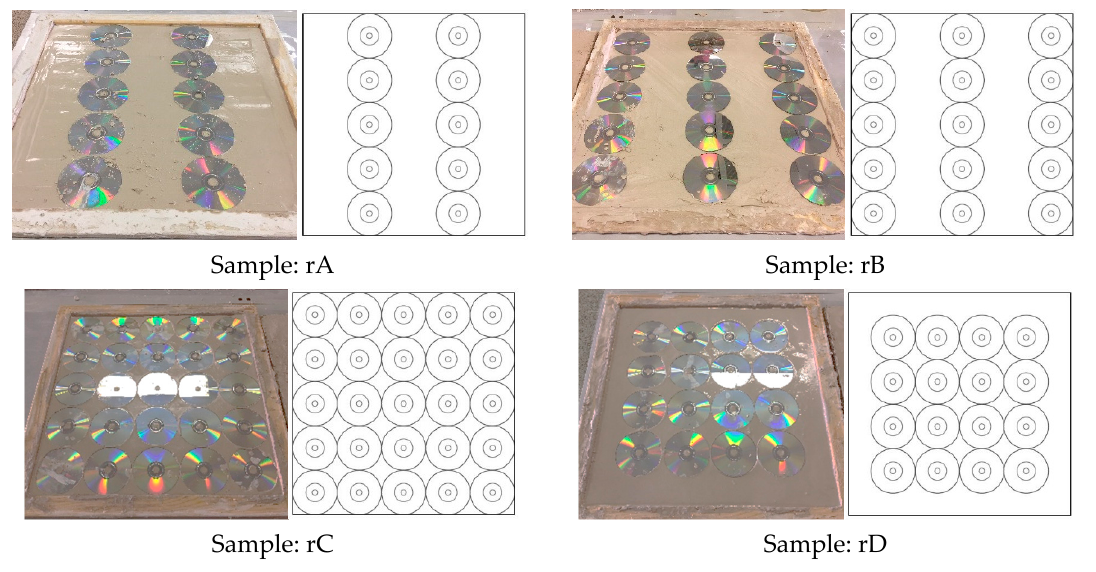
Figure 4 . Test plates prepared for Scenario 2. Figure 4. Test plates prepared for Scenario